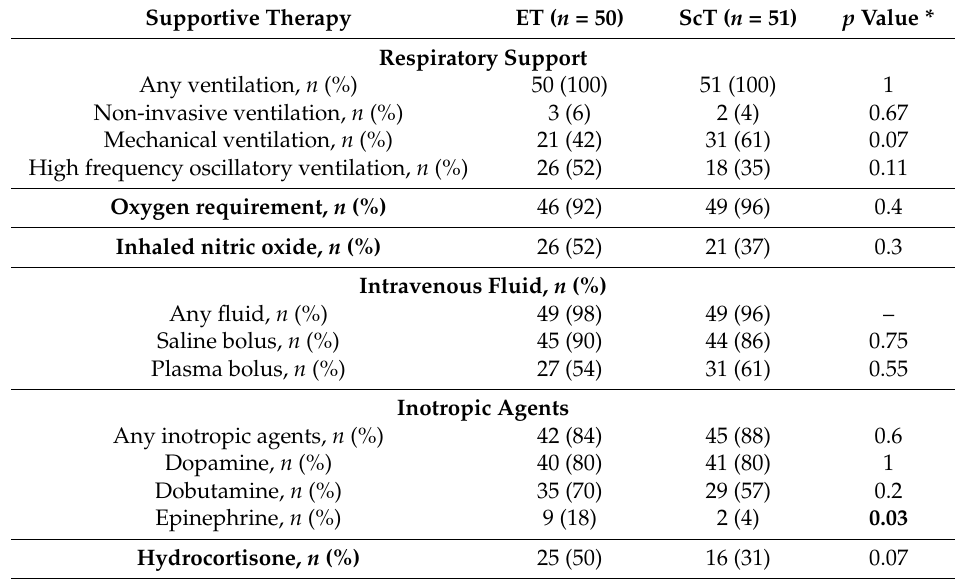
Table 5. Supportive therapy for the study population at the onset of septic